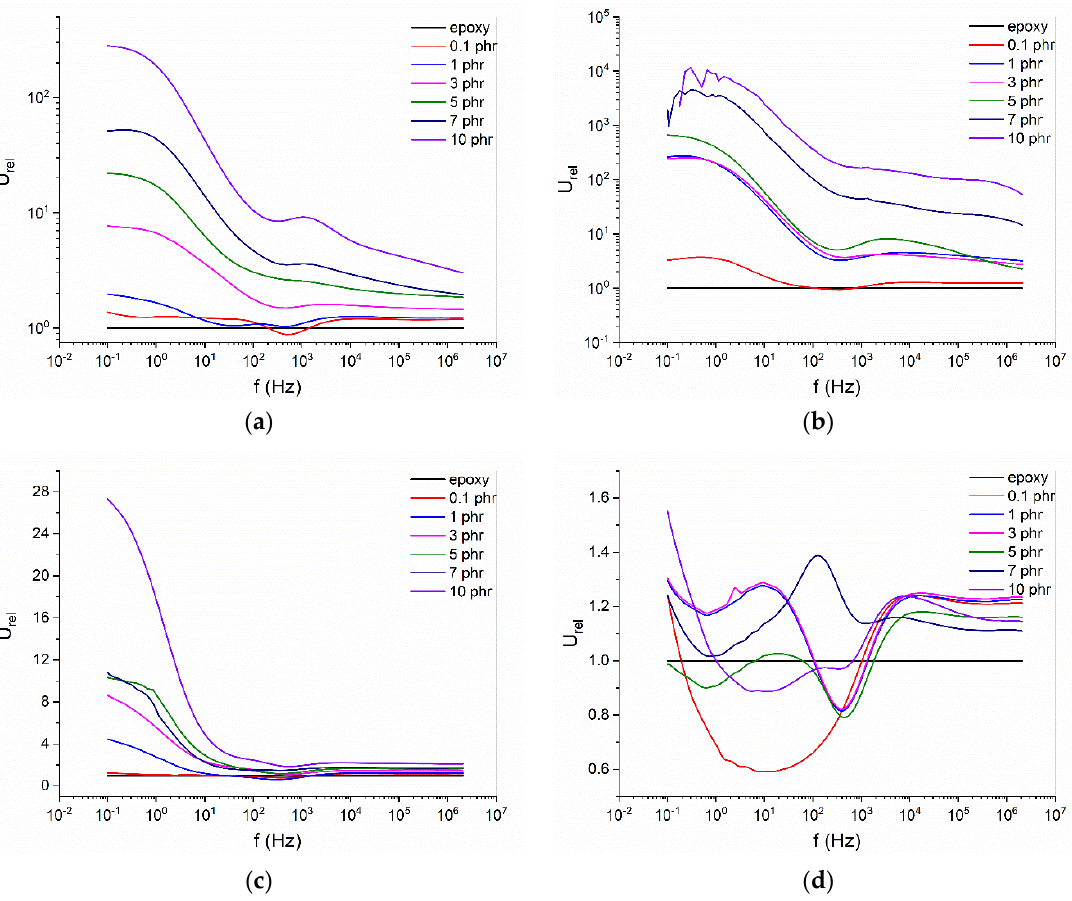
Figure 6. The variation of U relative as a function of temperature at 160 °C for the nanocomposites with ( a ) carbon black; ( b ) MWCNT; ( c ) GnP; ( d ) ND.